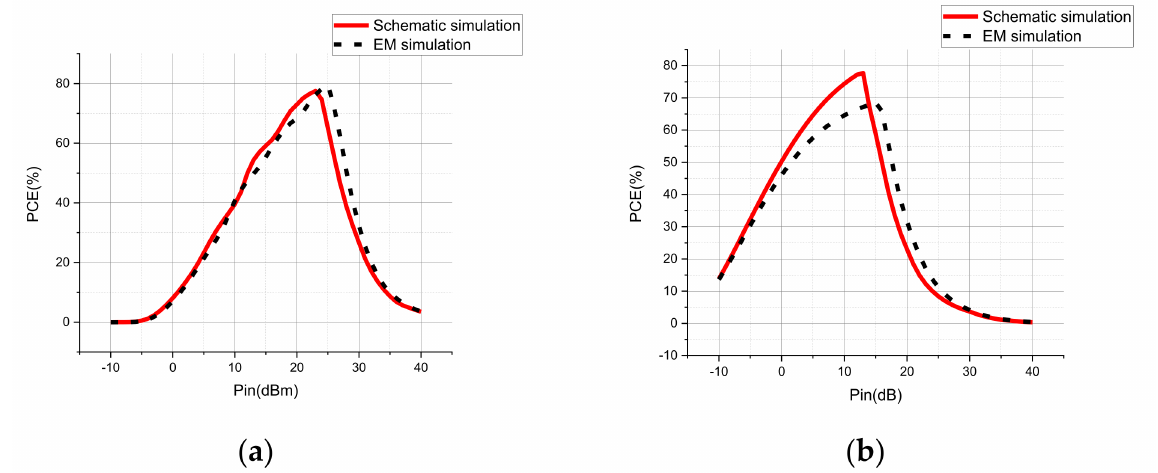
Figure 7. Single RF-DC circuit efficiency–input power curve. ( a ) Rectification efficiency–input power curve of the HSMS2820 circuit; ( b ) rectification efficiency–input power curve of the HSMS2860 circuit.